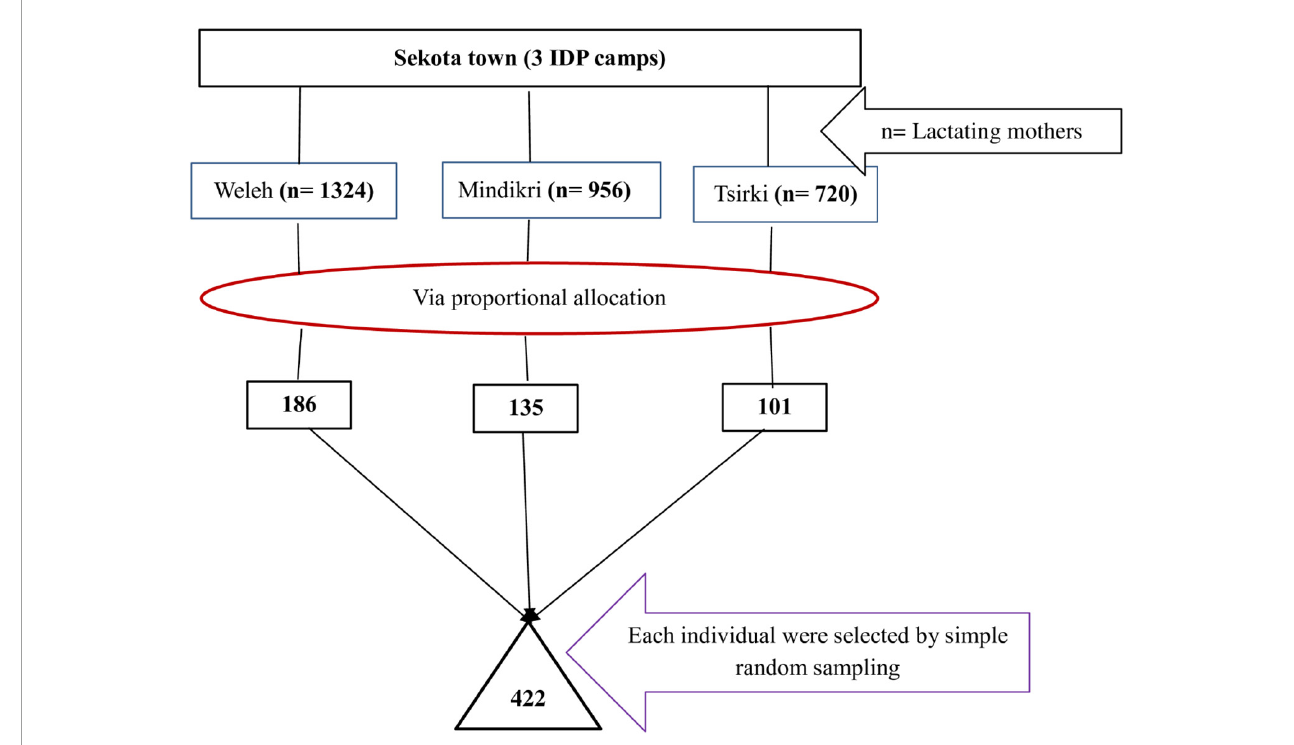
FIGURE1 Schematic presentation of the sampling procedure for the study conducted among lactating mothers in Sekota camps, Ethiopia,